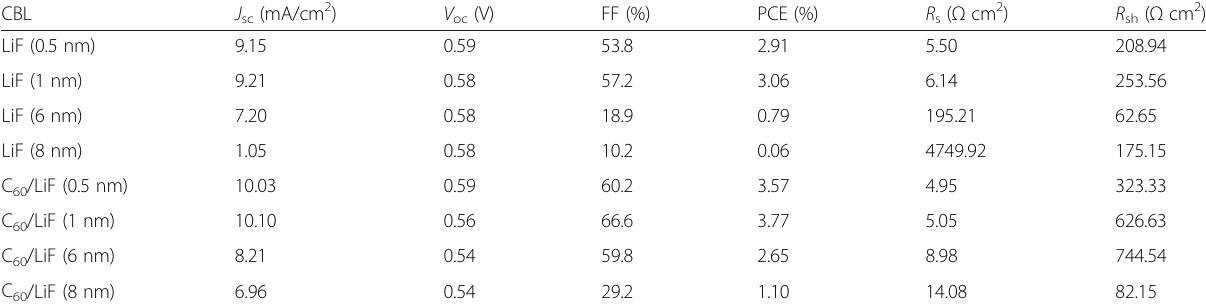
Table 2 Photovoltaic parameters for the P3HT:PCBM-based PSCs using LiF single and C 60 (25 nm)/LiF double CBLs with different thicknesses of LiF CBL